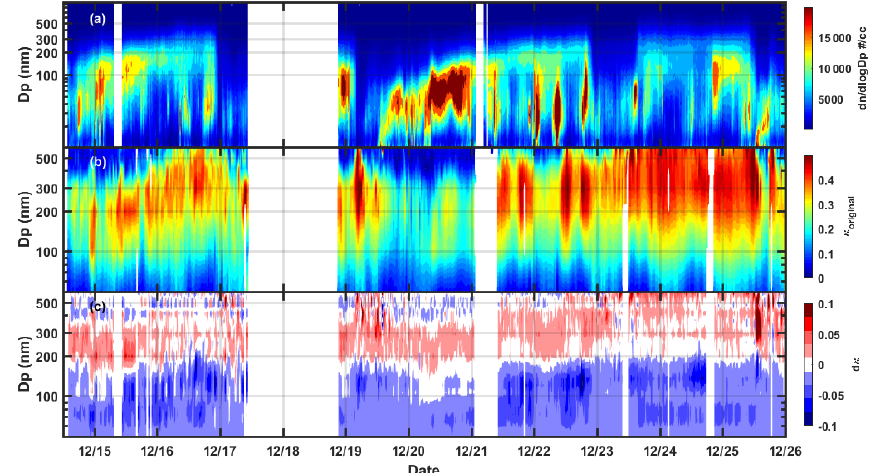
Figure 6. Field measurements of the PNSD and size-resolved hygroscopicity during a winter in Beijing. (a) The fill color indicates the particle number concentration for a particular diameter D p . (b) The fill color represents the size-resolved hygroscopicity parameter κ . (c) The fill color indicates the difference d κ between the measured and multi-charge-corrected κ values, i.e., d κ = κ corrected − κ measured